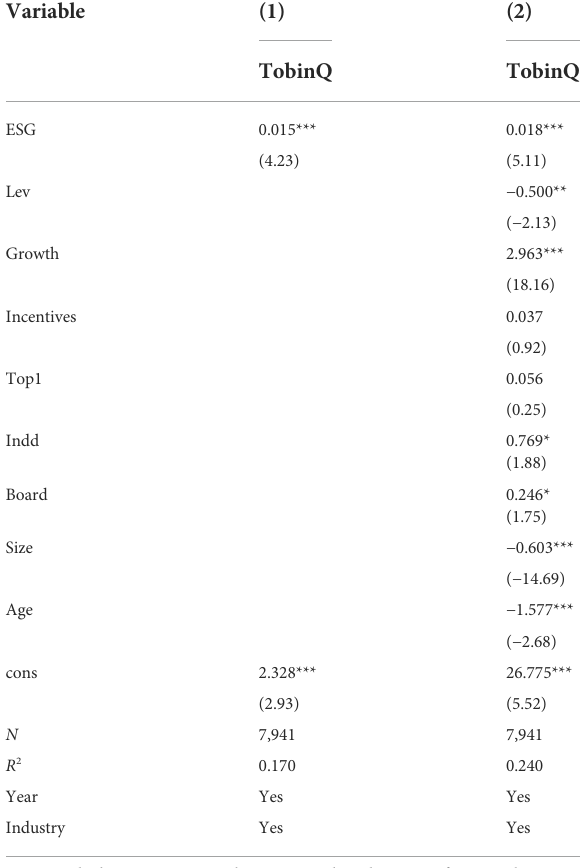
TABLE 4 Benchmark